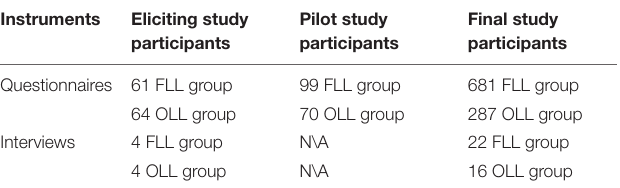
TABLE 2 | Steps and procedures of data collection, analysis, and